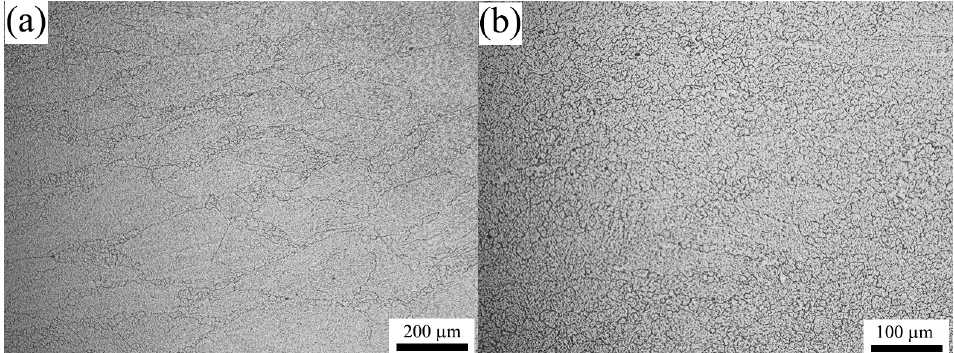
Figure 12. Typical deformed microstructures of 70MnSiCrMo carbide-free bainitic steel obtained at 1373 K and 0.1 s − 1 with low strains of ( a ) 0.162 and ( b ) 0.357.